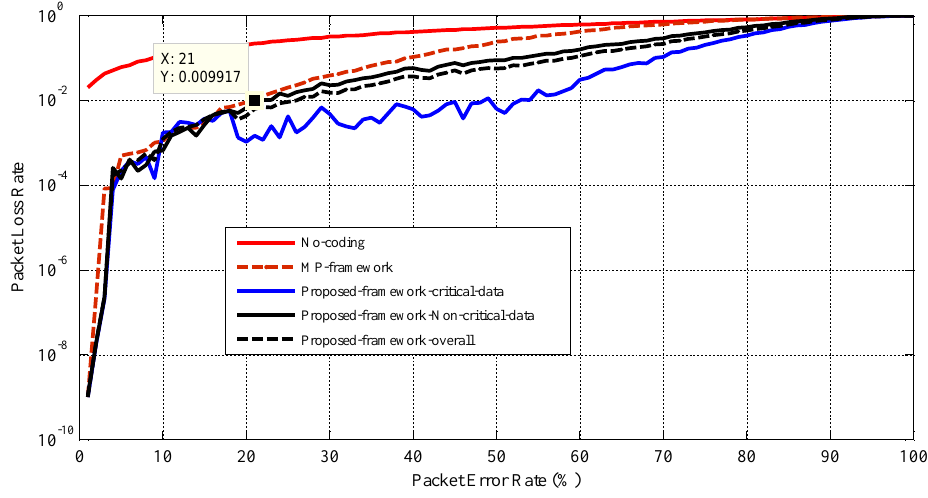
Figure 10. Performance comparison in terms of